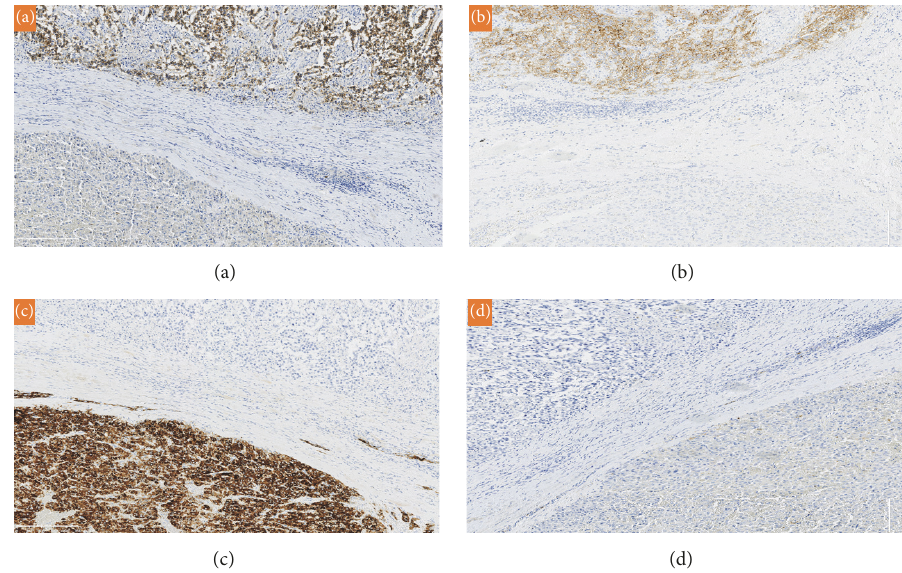
Figure 2: Immunohistochemical staining of the seminoma and Leydig cell tumor. (a) The seminoma cells (top) stained positively for (a) CD117 and (b) PLAP, while the Leydig cell tumor (bottom) was negative for both markers. (c) Inhibin immunostain is positive in the Leydig cell tumor (bottom) and negative in the seminoma (top). (d) Both the seminoma (top) and Leydig cell tumor (bottom) are negative for cytokeratin ( × 4000